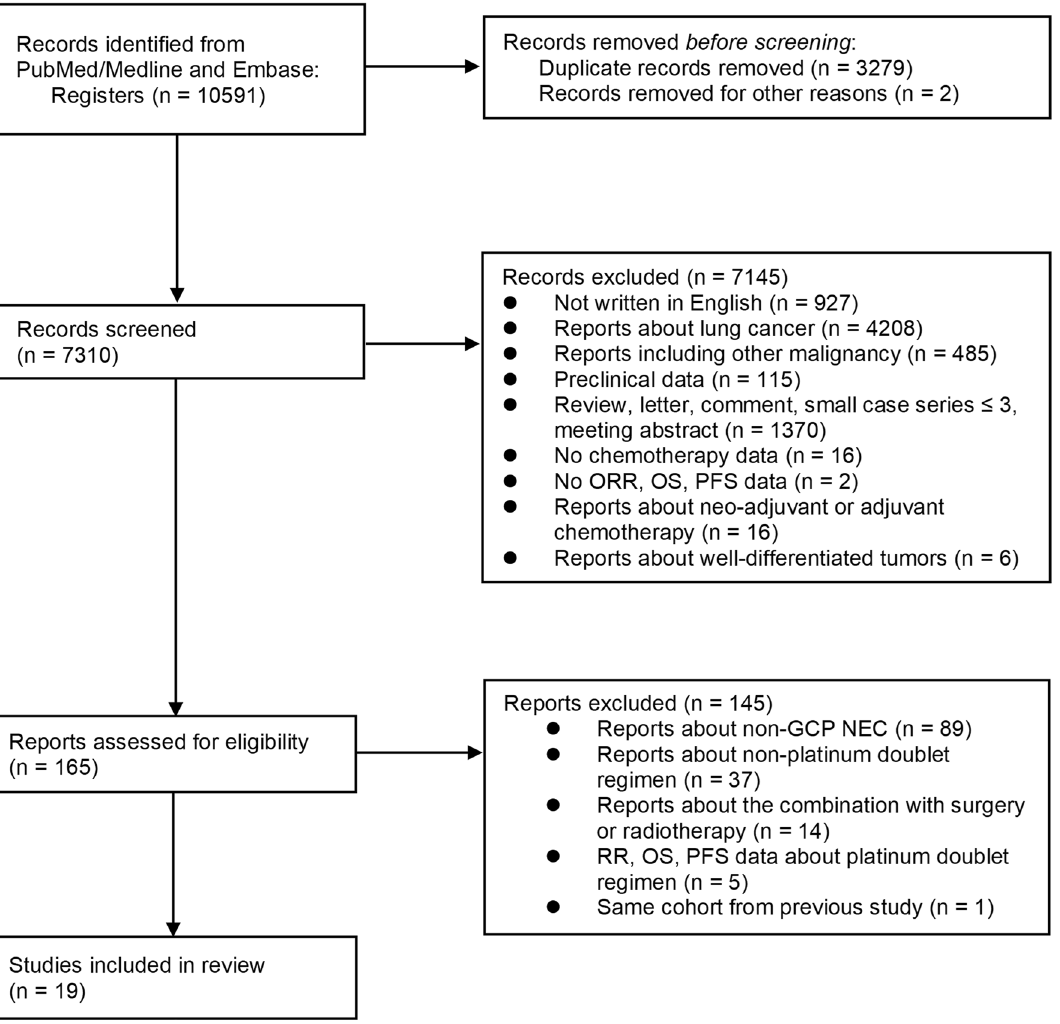
Fig. 1 Flowchart of the systematic review process. On the basis of the initial screening and eligibility assessment, 19 studies with 1157 patients were